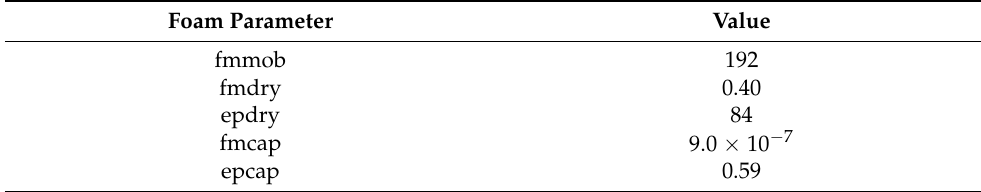
Table 3. Base case foam parameters.